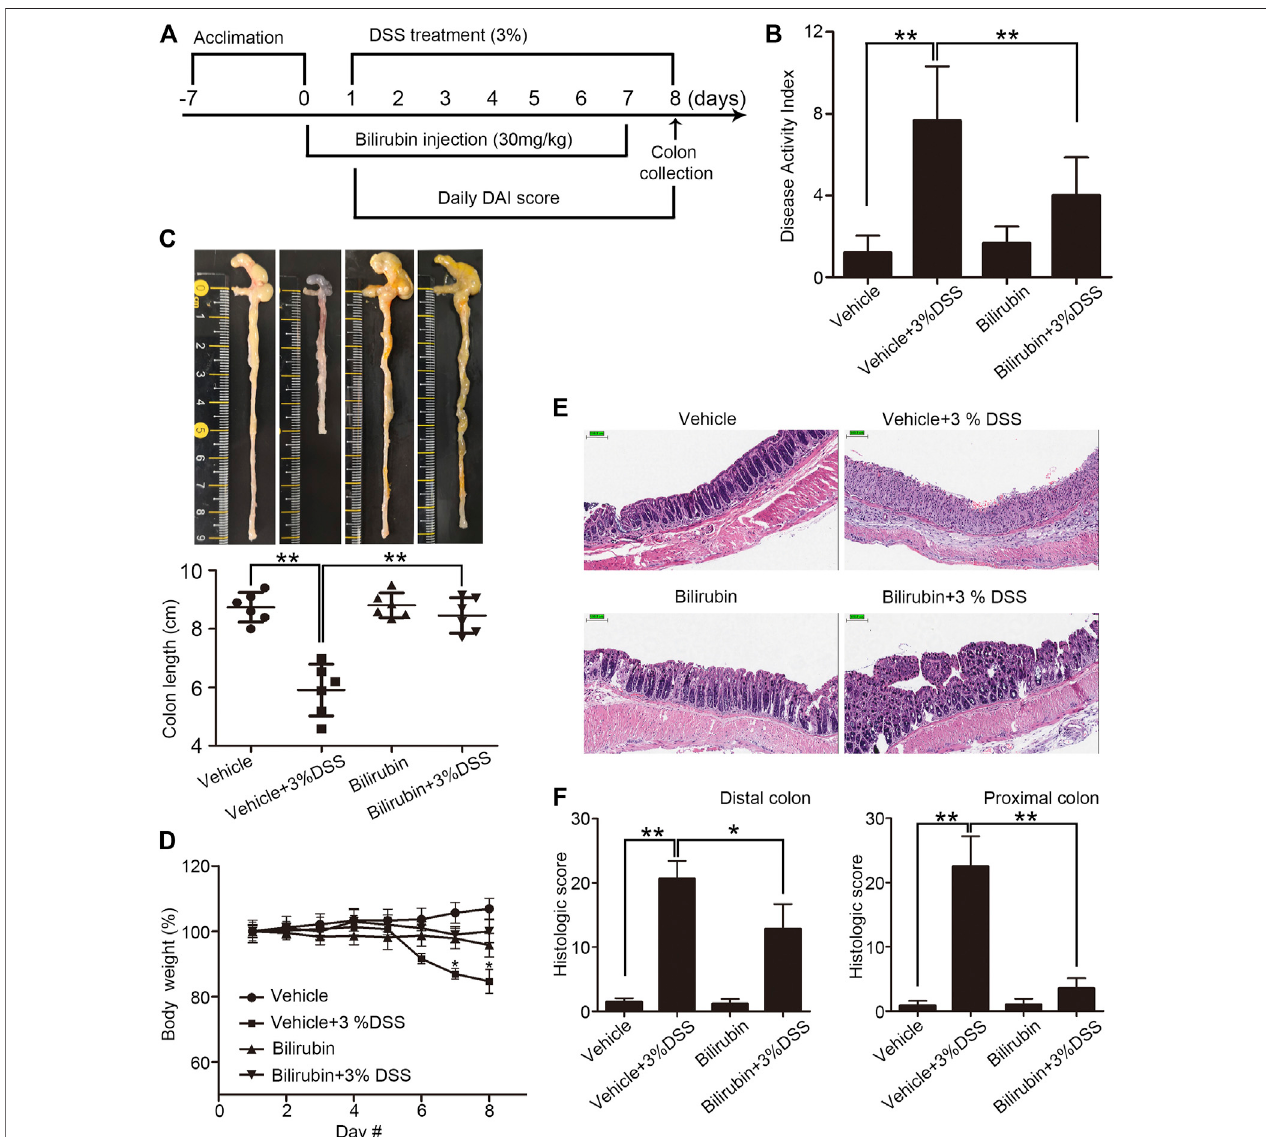
FIGURE 1 | Effect of bilirubin on DSS-induced colitis. (A) Experimental design. (B) Disease activity index scores (DAI) in the indicated mice. Data are expressed as mean ± SEM ( n (cid:2) 6); ** p < 0.01. (C) Macroscopic appearance (top) and the length of colons (bottom) in the indicated groups. Data are expressed as mean ± SEM ( n (cid:2) 6); ** p < 0.01. (D) Body weight of mice during the experiment duration. Data were normalized as percentage of basal body weight. * p < 0.05 vs. the colitis group. (E) Representative images of HE-stained colon tissue sections in the indicated groups. Bar (cid:2) 100 μ m. (F) Mean histological scores of distal (left) and proximal (right) colon in the indicated groups. Data are expressed as mean ± SEM ( n (cid:2) 6); * p < 0.05 and ** p < 0.01.